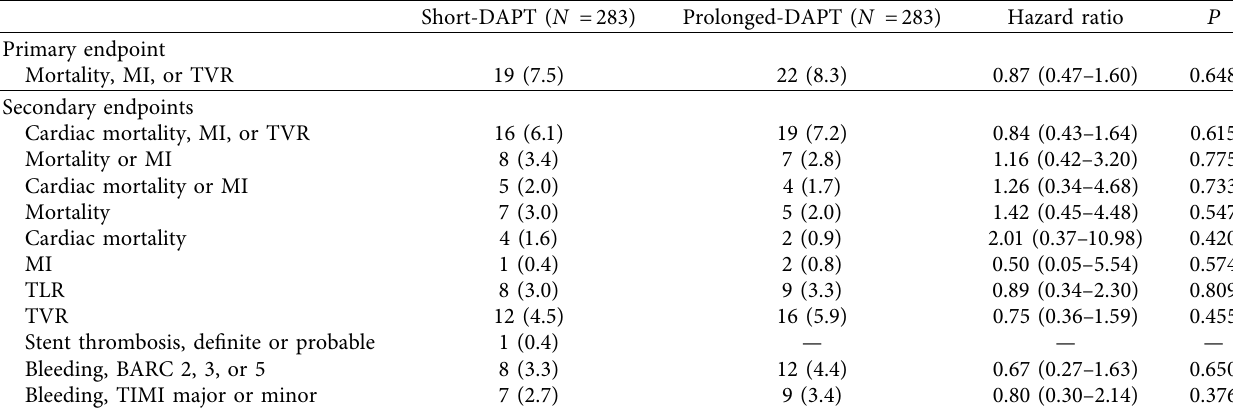
Table 3: Primary and secondary endpoints between the short-DAPT and prolonged-DAPT groups in the matched